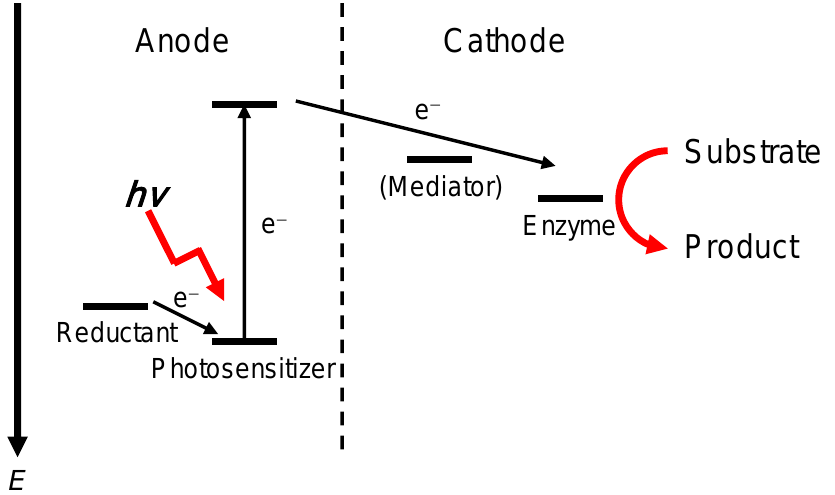
Figure 6. Potential profile in a simple photo-bioelectrocatalytic system.